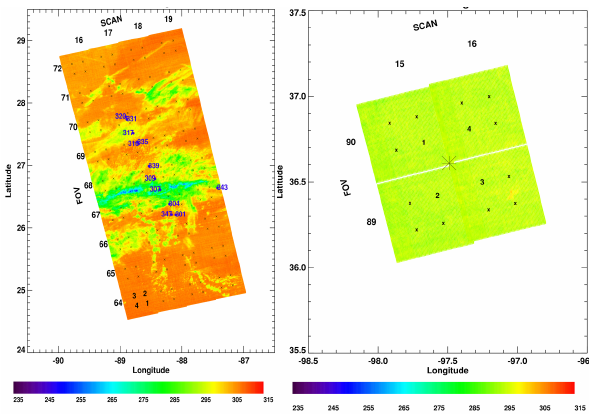
Fig. 2. Plotted are maps of IASI imager brightness temperatures showing location of IASI measurements relative to sonde locations. The numbered dots over the Gulf of Mexico (left) indicate the drop- sonde locations. The star in the ARM SGP (right) case shows the lo- cation of the radiosonde launch. Overplotted on the maps are small crosses indicating the location of the IASI footprints labeled as a function of SCAN and FOV. The four pixels used in the average for the two cases are numbered in